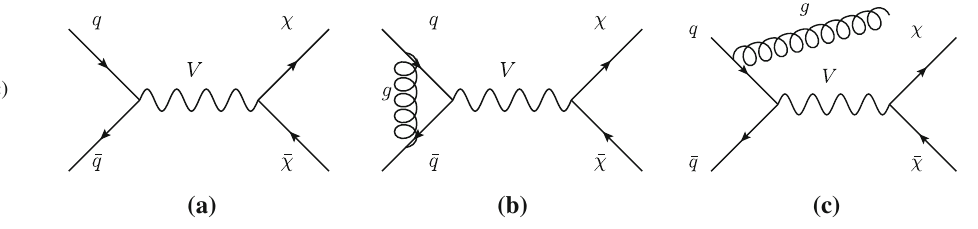
Fig. 1 Feynman diagrams for DM pair production in the s -channel model at LO ( a ) and representative diagrams for the virtual ( b ) and real-emission ( c )